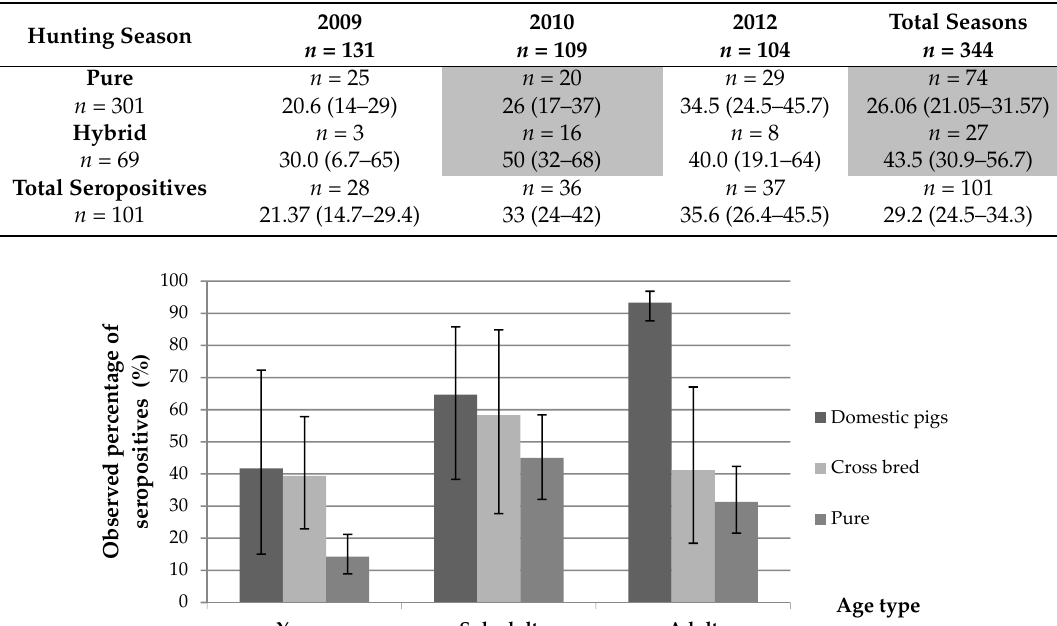
Table 2. Sample size ( n ), seroprevalence (%) and 95% confidence intervals from phenotypically distinct wild boars (pure and hybrid) across the three hunting seasons (2009, 2010 and 2012). Differences between animals classified as pure and hybrids were significant (in grey) for the 2010 season ( p = 0.01) and for all seasons ( p = 0.006).